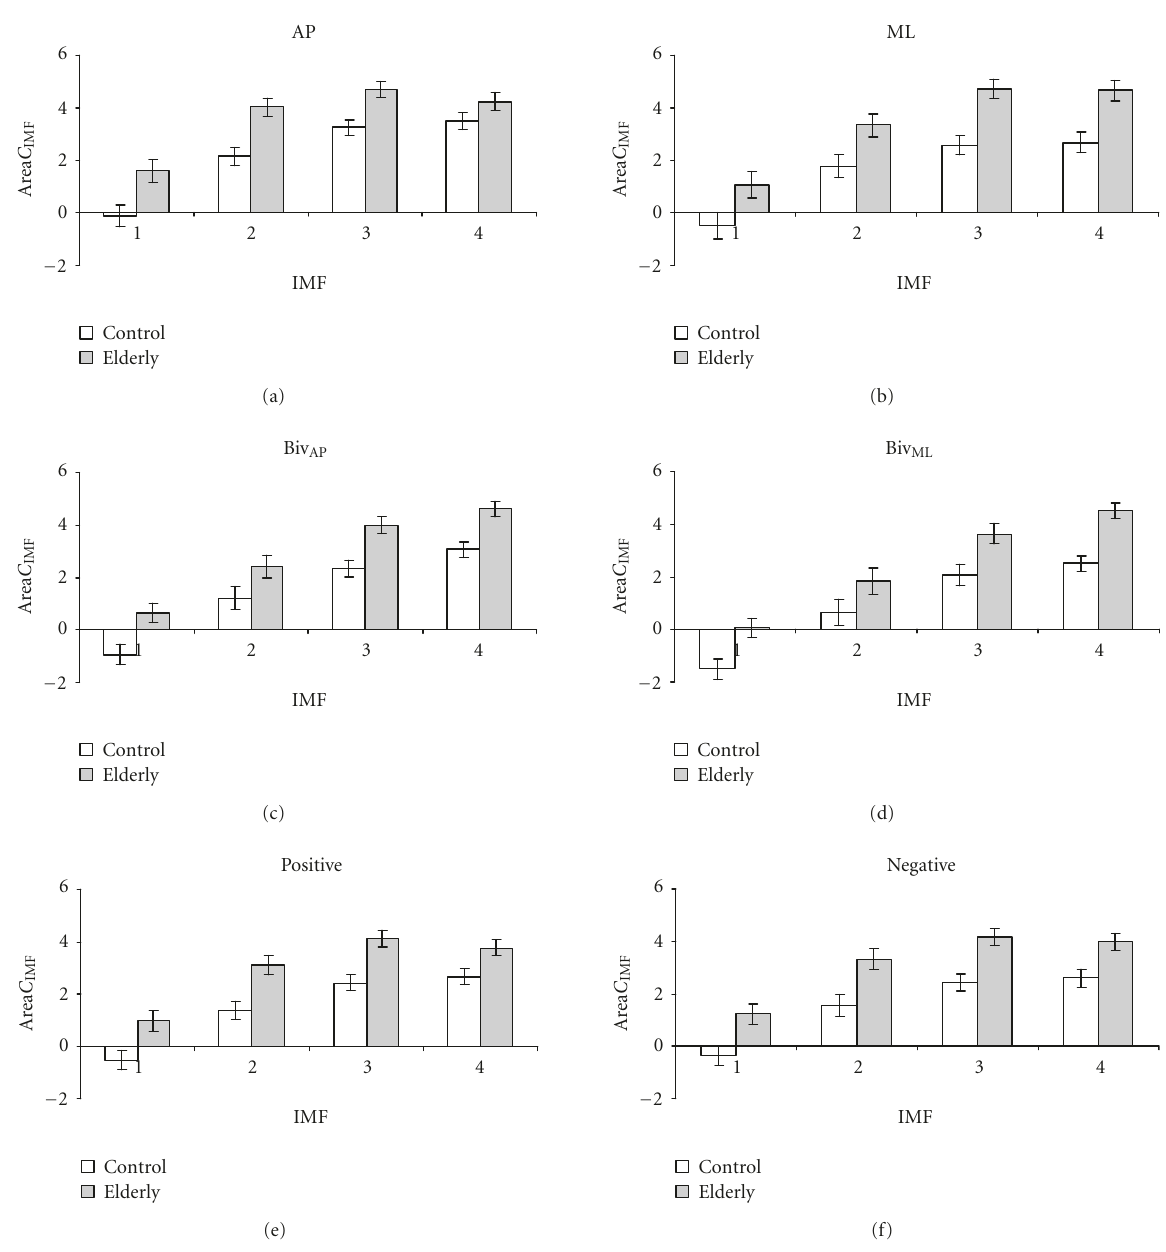
Figure 5: The surface area of the analytic signal in a logarithmic scale (Area C IMF ) of the first four IMF for control and elderly subjects. (a) EMD for AP displacement; (b) EMD for ML displacement; (c) bivariate-EMD for the imaginary part of the signal (corresponding to AP displacement); (d) bivariate-EMD for the real part of the signal (ML); (e) complex-EMD for positive components; and (f) complex-EMD for negative components. Data are mean and 95% confidence intervals. All comparisons are significantly di ff erent between groups.